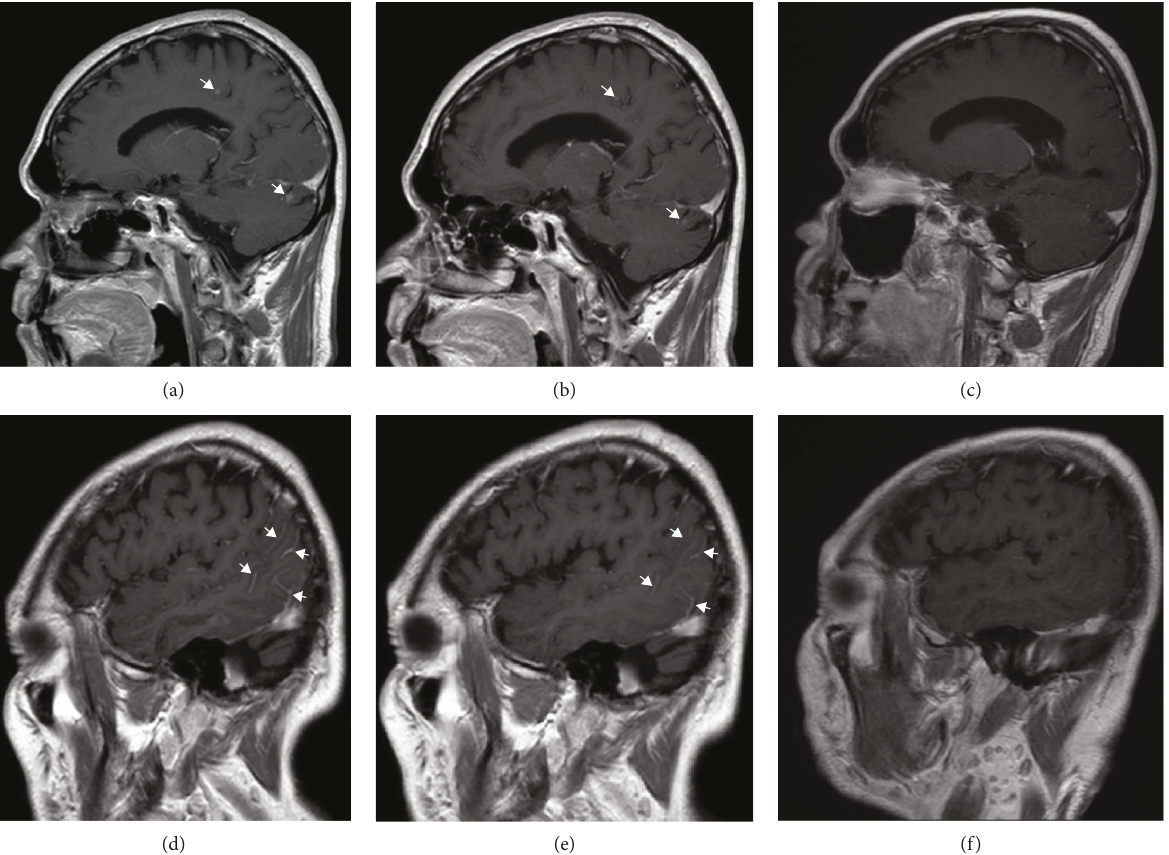
Figure 1: T1 WI postgadobutrol administration sagittal slices. (a, d) Nodular enhancing lesions between 1 and 4 mm (arrows) at the centrum semiovale and left cerebellar hemisphere. Additional leptomeningeal enhancement was noticed at the pial surface of the left posterior quadrant (arrows). (b, e) Images obtained 7 months later. There is evident reduction in lesion size, and fewer leptomeningeal enhancement is noticed. (c, f) Images obtained 11 months from fi rst study; no lesions or enhancement